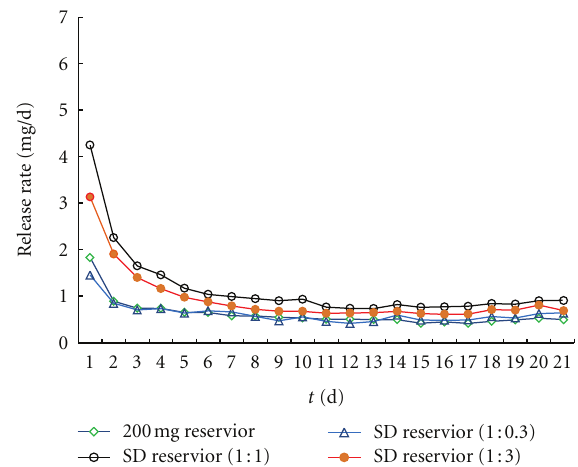
F 9: e in�uence of the PVP solid dispersion (SD) in reservoir-type IVR on the release of